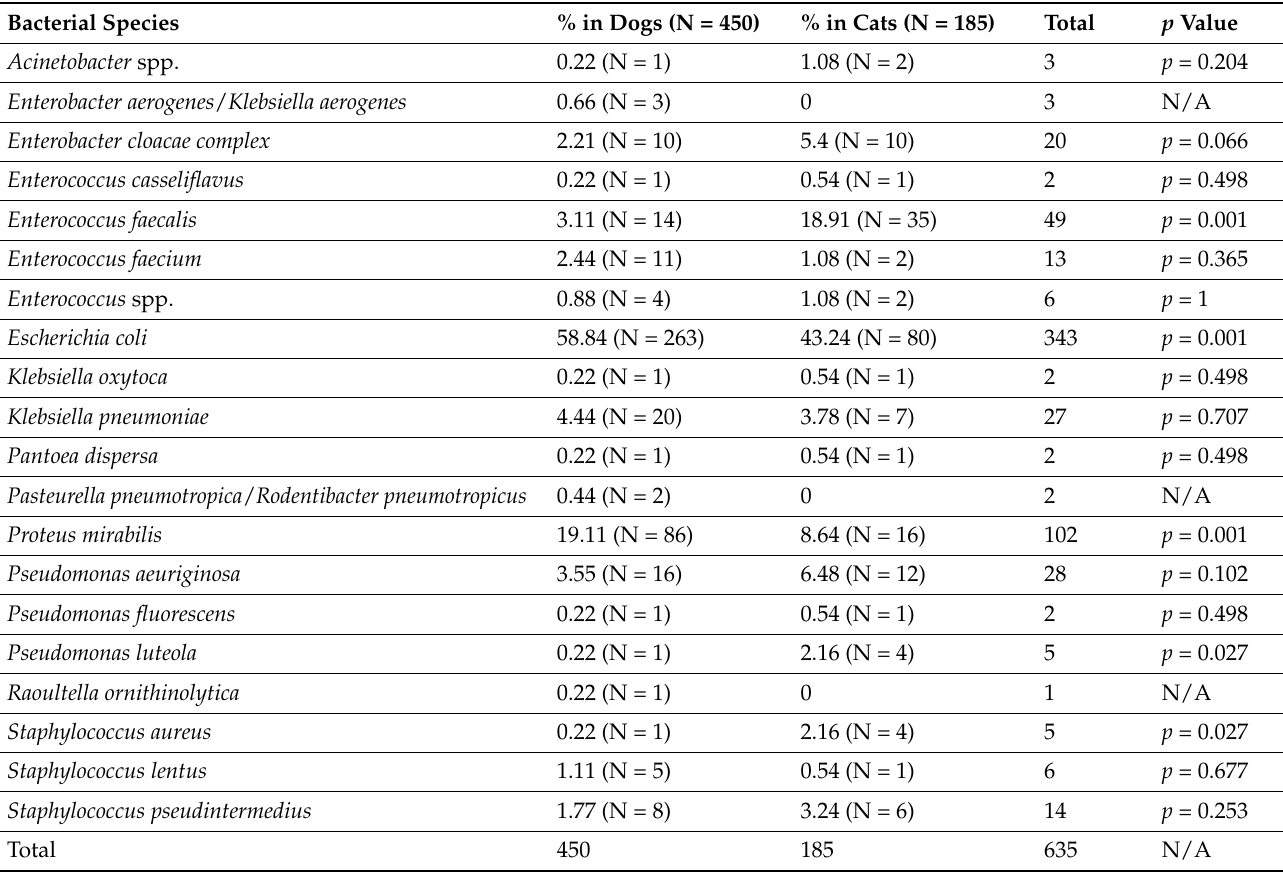
Table 1. Bacterial species isolated from urine samples of investigated dogs and